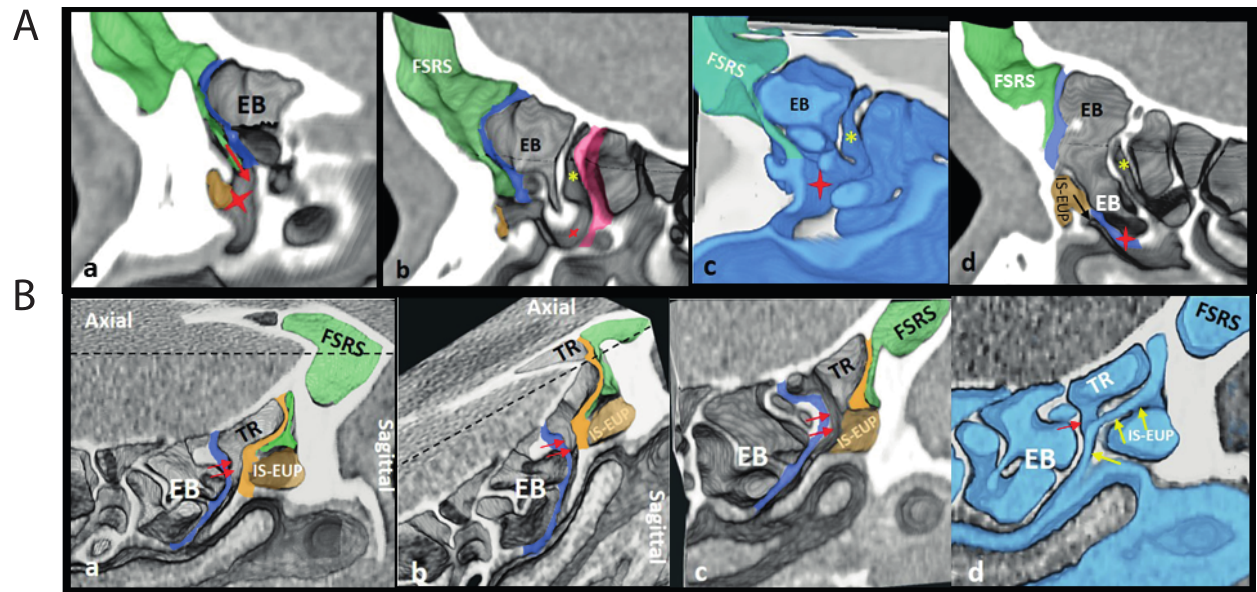
Figure 6. The “contracted/diminished” Frontal Recess. A. The “contracted/diminished” Frontal Recess altered by the Bulla Lamella. a.-d. 3D sagittal images in sequence from medial to lateral (right side), show the Bulla Lamella (blue outline), and the Ethmoid Bulla space (EB), expanding anteriorly into the FSRS (green outline). The FSRS drains directly (red arrow) into the Middle Meatus (red star). The IS-EUP (gold outline) is diminished in size, and drains directly into the Turbinal Infundibulum (black arrow). The retro-bullar recess space (yellow star) drains directly into the middle meatus (red star). Purple outline: basal lamella of the middle turbinate. B. The “contracted/diminished” Frontal Recess, altered by the Uncinate Lamella. a.-d. 3D sagittal images (left side) sequentially from medial to lateral. A Terminal Recess space (TR) is created between the antero-superiorly extend- ing UL (gold outline), and the bulla lamella arising from the ethmoid uncinate roof superiorly fusing with the skull base with the posterior border being the BL (blue outline). The TR space diminishes the frontal recess, as it extends to the posterior FS (FSRS, green outline) and drains into the EI (red arrows). Fig. d, shows the air spaces within the anterior ethmoid sinus, the FSRS, the TR space draining into the EI (red arrow), and the FSRS draining postero-medially into the middle meatus (yellow